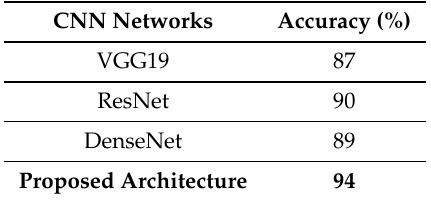
Table 9. Accuracy with other CNN